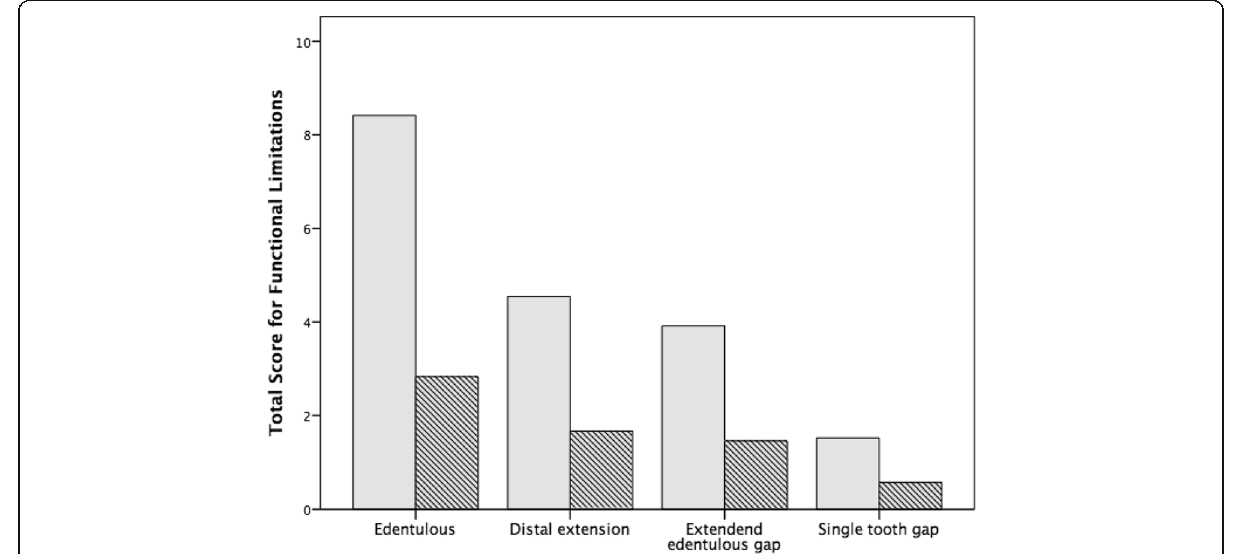
Fig. 4 Total score for functional limitations before ( gray ) and after ( hatched ) sinus augmentation according to